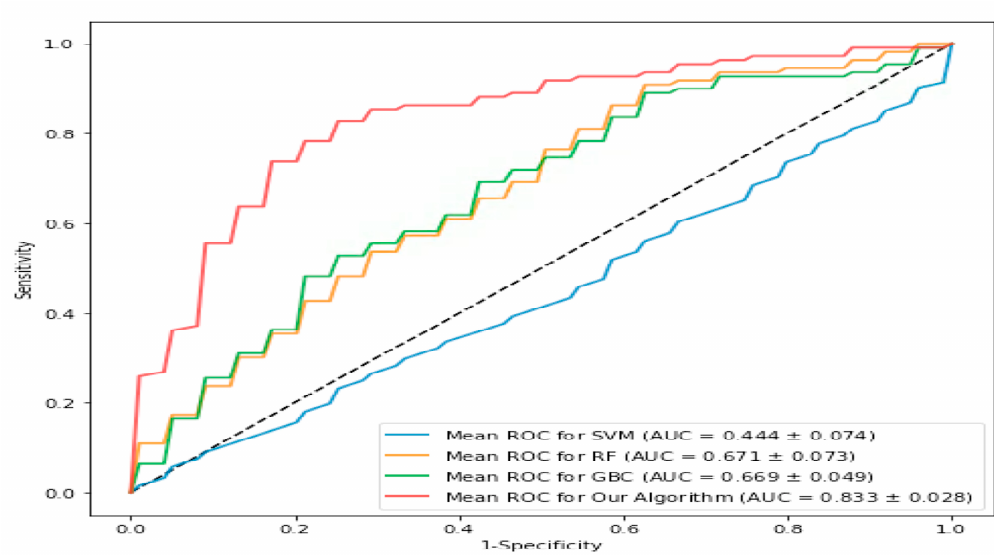
Figure 5. Receiver operating characteristic curves of the detection of wound infection between the four models (SVM: blue; RF: yellow; GBC: green; our model: red). The receiver operating characteristic curve is a probability curve, and the area under the receiver operating characteristic curve (AUC) characterizes the degree of separability. One model with a higher AUC score is better at detecting the aimed outcome. AUC values in these four models range from 0.444 to 0.833; our model achieves the best performance.